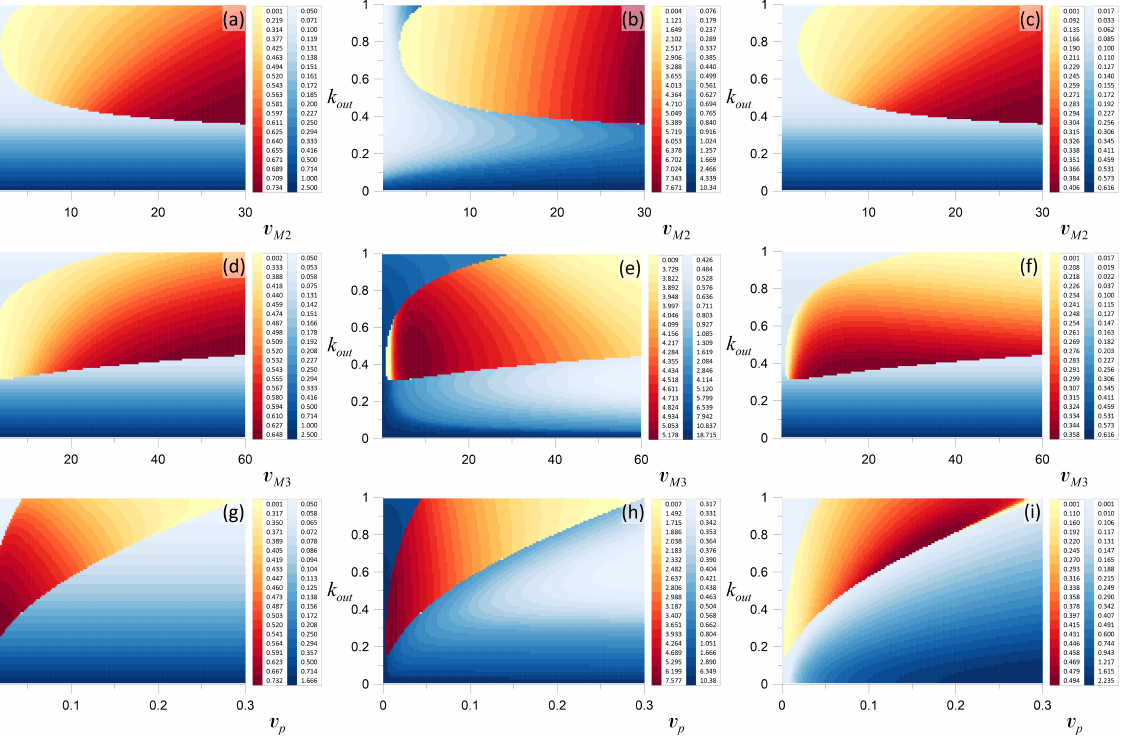
Figure 5. Two-parametric diagrams obtained for [ Ca 2 + ] cyt ( a , d , g ); [ Ca 2 + ] ER ( b , e , h ); and [ IP 3 ] cyt ( c , f , i ); and for ( a – c )—( v M 2 , k out ) parameter space; ( d – f )—( v M 3 , k out ); and ( g – i )—( v p , k out ) parameter space. Domains shown in blue correspond to a steady state solution. The intensity of the color demonstrates the change of the corresponding variable in equilibrium. The difference between the minimal and the maximal value of the corresponding variable in the oscillatory regime is shown by a red-to-yellow